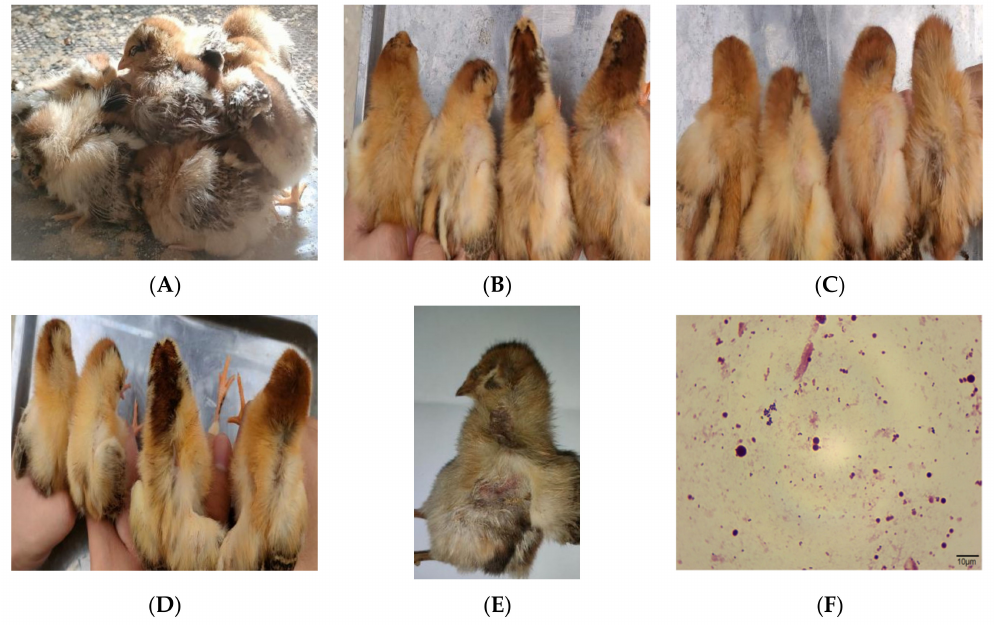
Figure 6. ( A ) The status of the experimental group chicks three days post-infection. ( B ) Three days after infection. Left: feather condition of control group chicks, middle left: 3 × 10 5 cfu intraperitoneal injection chicks, middle right: 3 × 10 7 cfu intraperitoneal injection chicks, right: 3 × 10 8 cfu in- traperitoneal injections checks. ( C ) Four days after infection. Left: feather condition of control group chicks, middle left: 3 × 10 5 cfu i.p. chicks, middle right: 3 × 10 7 cfu i.p. chicks, right: 3 × 10 8 cfu i.p. chicks. ( D ) Four days after infection. Left: feather condition of control group chicks, middle